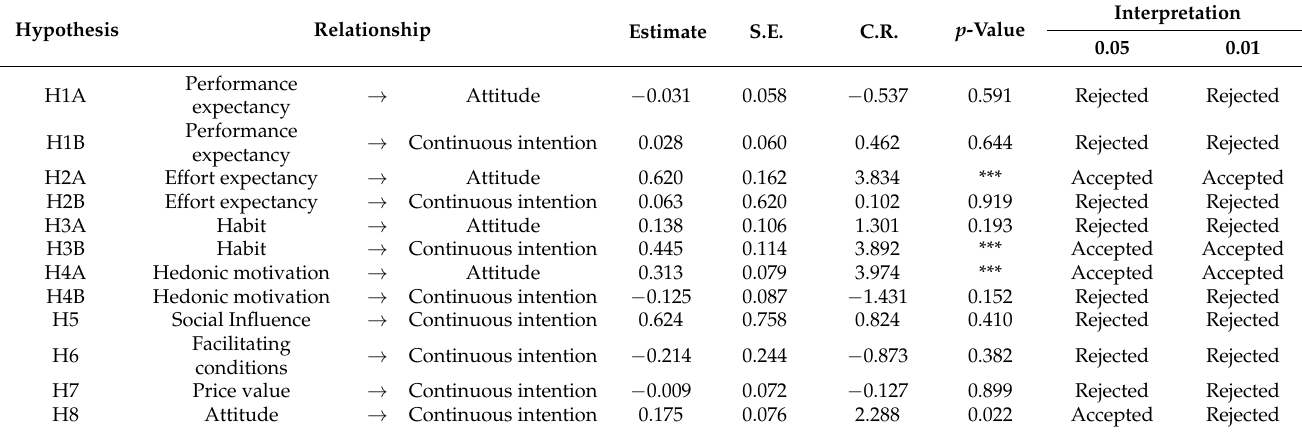
Table 6. Hypothetical analysis. Note: *** p <